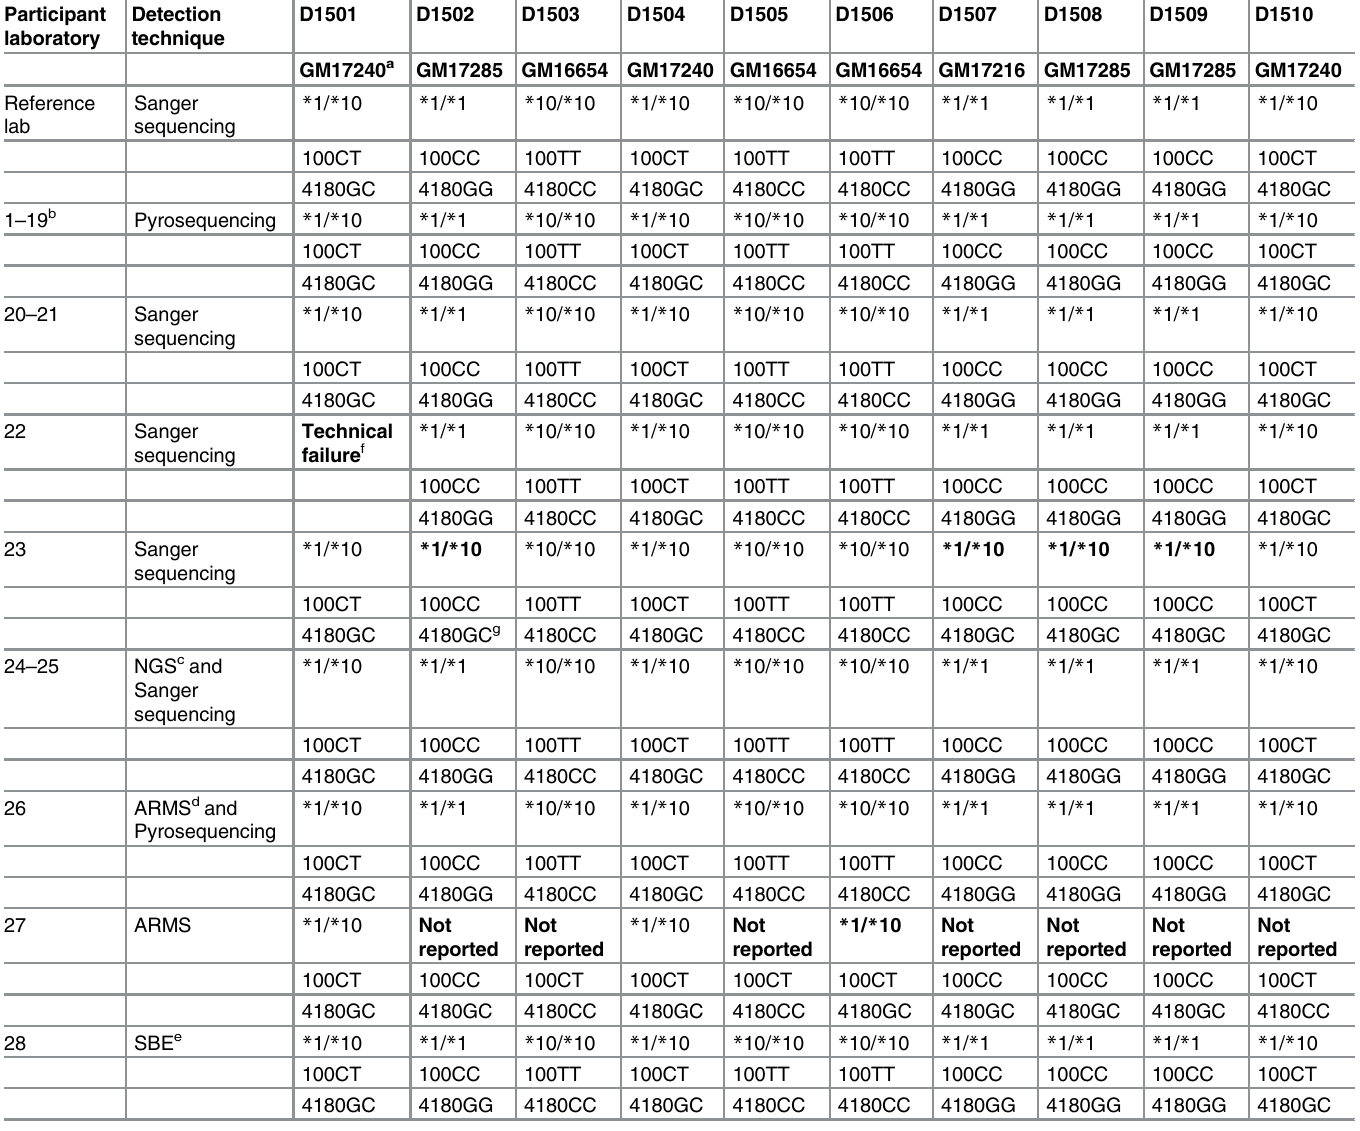
Table 1. Genotyping results of the 28